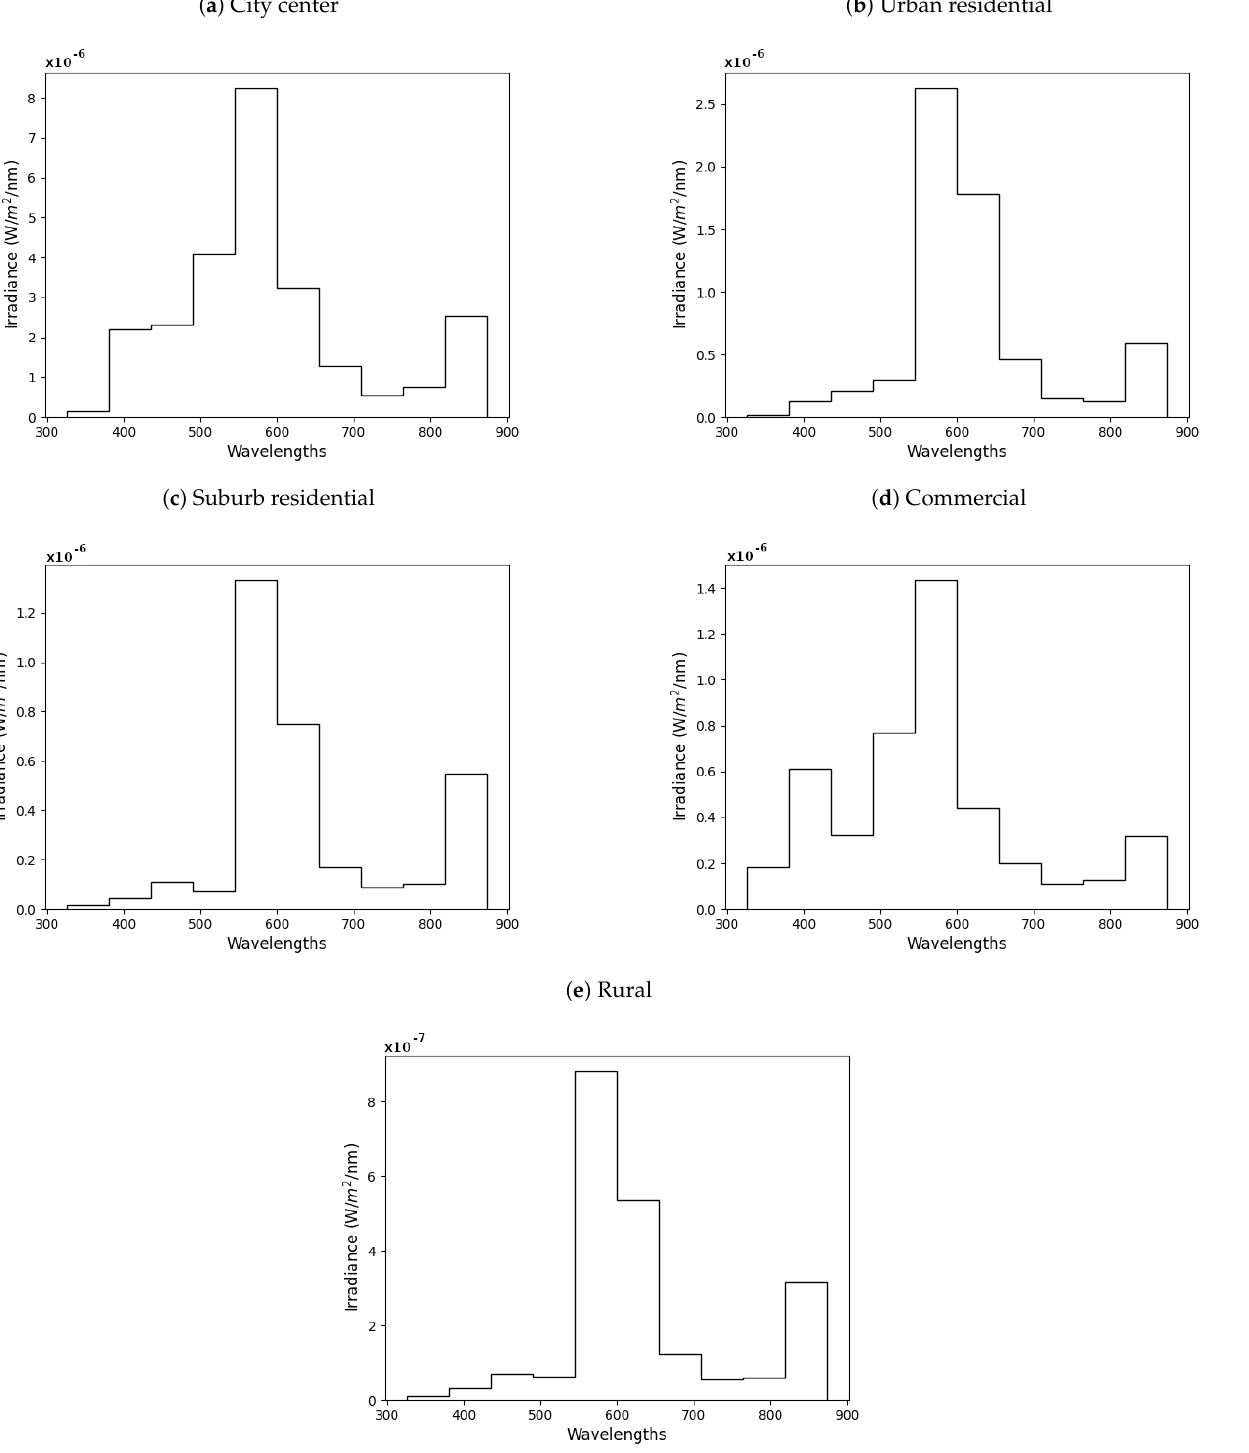
Figure 10. Spectral irradiance on windows 2 m above ground for the five test sites identified in Table 3. Panel ( a – e ) show respectively the spectral irradiance for the city center, the urban residential, the suburb residential, the commercial and the rural